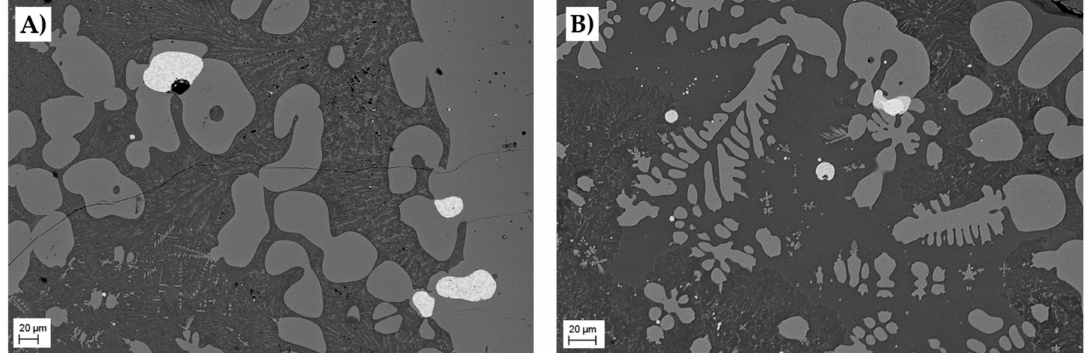
Figure 4. Microstructures of oxidation-reduction experiments ( A ) O-R1 and ( B ) O-R3. The darker matrix is the liquid slag phase and the medium grey areas are the spinels. Light grey and white spots are metal or speiss droplets formed during the reduction stage.